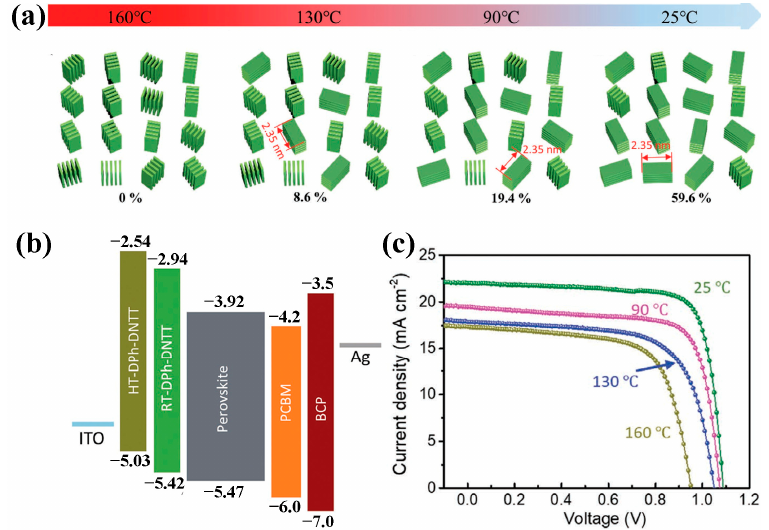
Figure 10. ( a ) The dependence of face-on ratio on the temperature of substrate during evaporation. ( b ) Energy level alignments in p-i-n devices with different HTLs. ( c ) J - V curves of devices based on different HTLs. Adapted with permission from Ref. [54]. Copyright 2021 John Wiley and Sons.